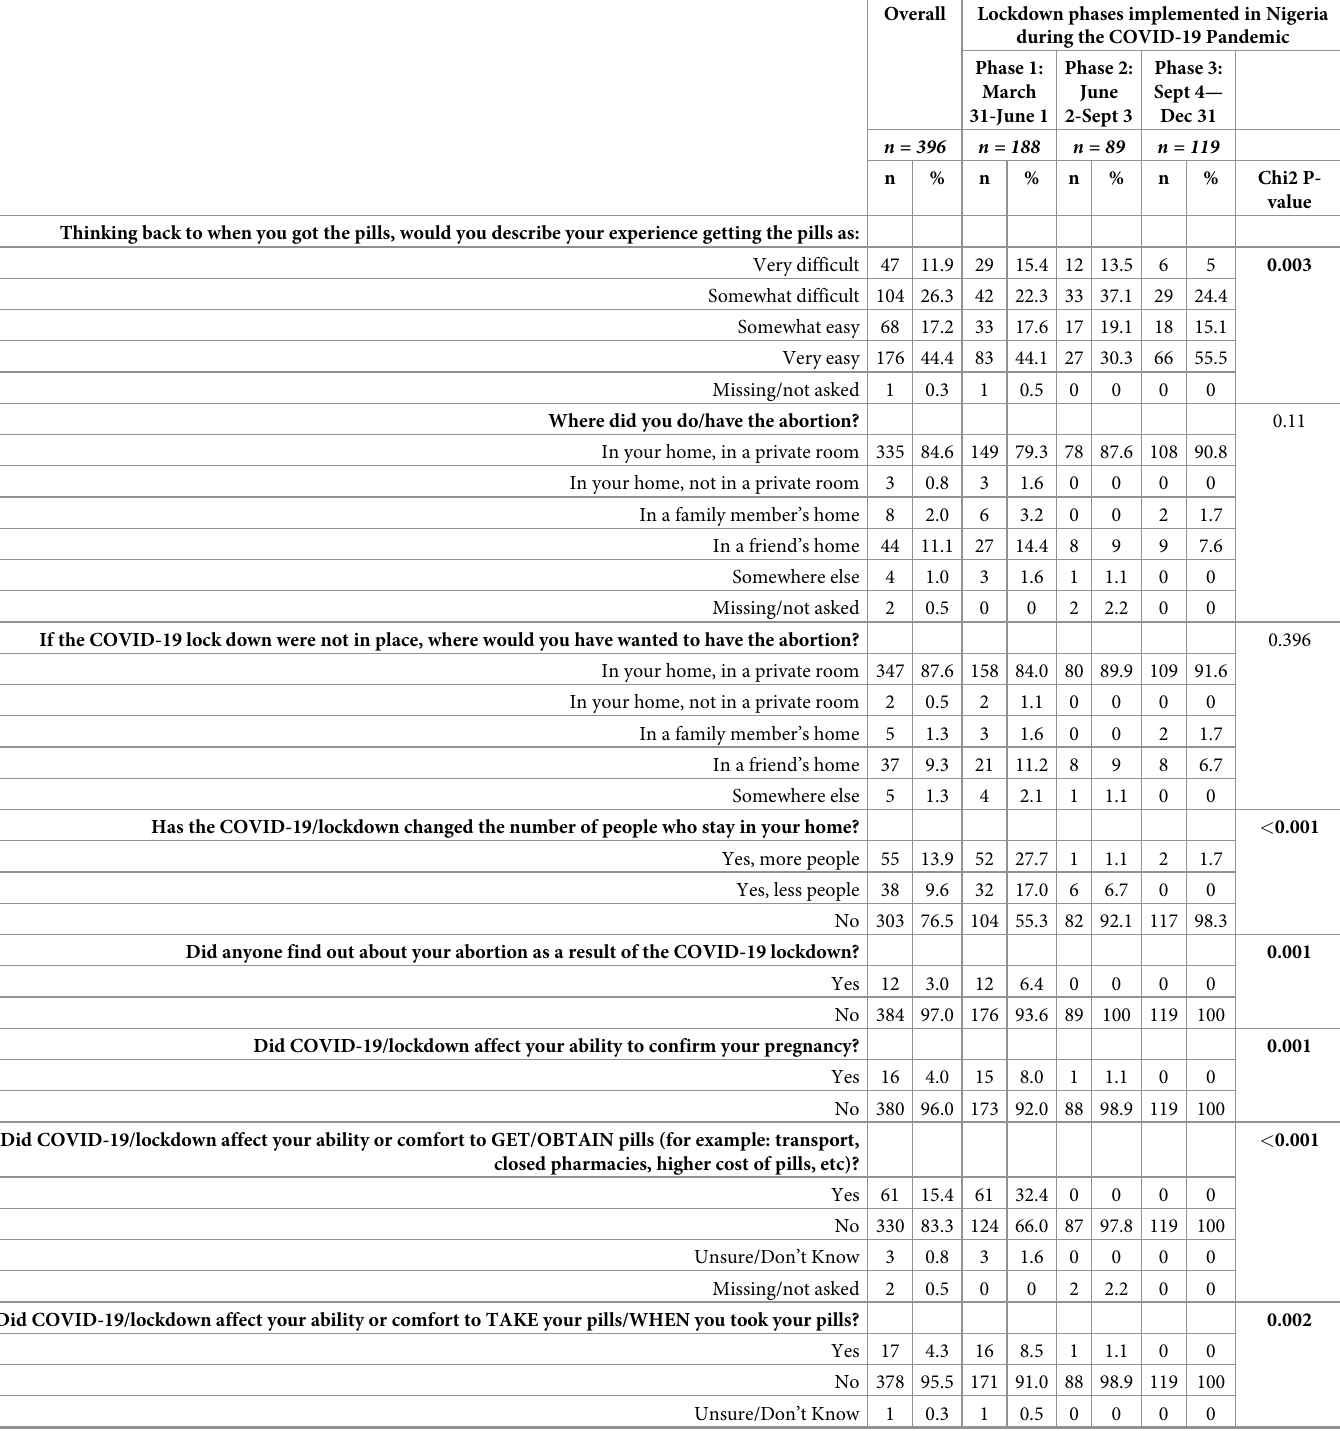
Table 3. Steps in the self-managed abortion process across phases of the COVID-19 pandemic reported by 396 callers to a safe abortion hotline in Nigeria between March and December 2020. A pre-COVID period is not included in this table as these questions were not asked prior to the COVID-19 pandemic.